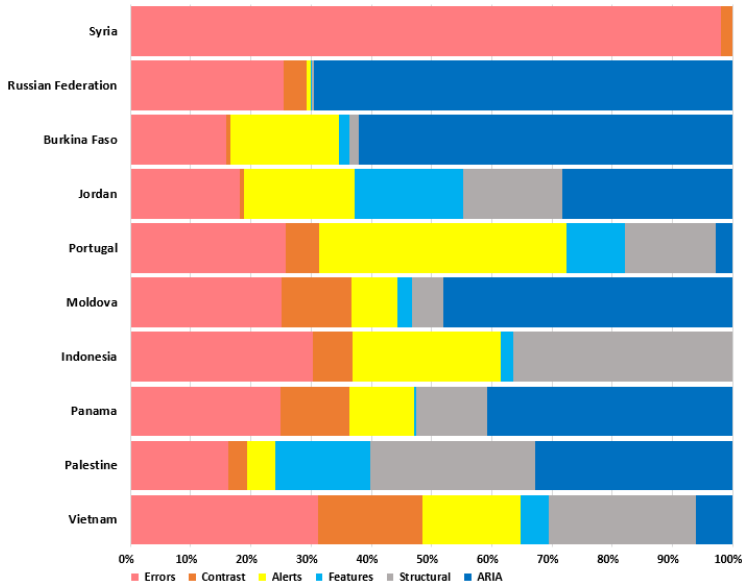
Figure 5. Summary of top 10 websites with the highest number of accessibility issues .